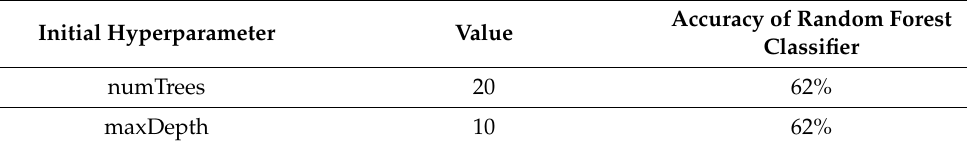
Table 3. Initial hyperparameters of the developed random forest